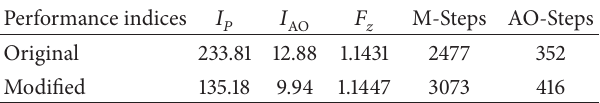
Table 4: Five performance indices from the load follow simulation of the original and modified power control system in